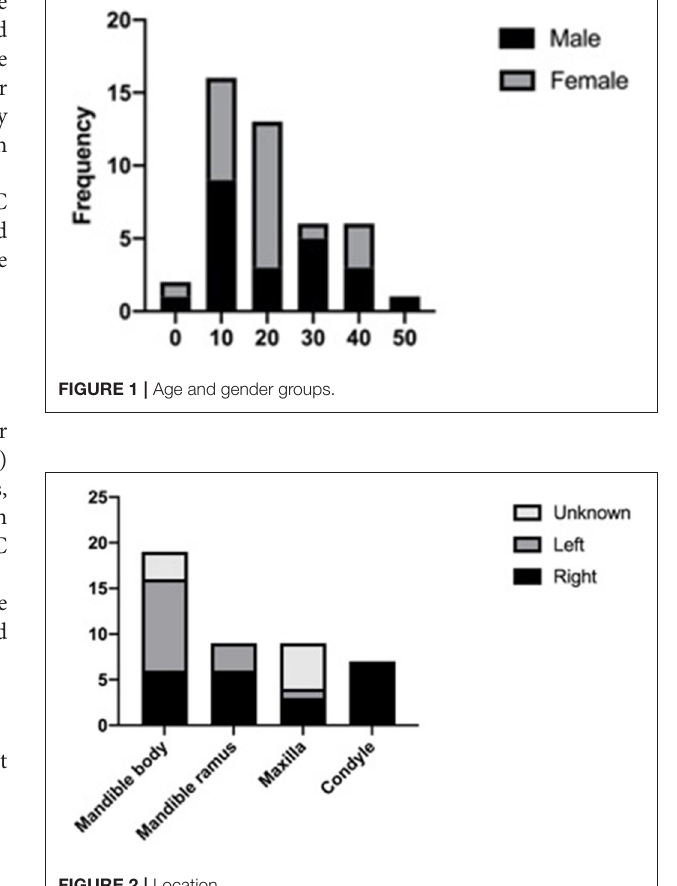
FIGURE 2 | Location.